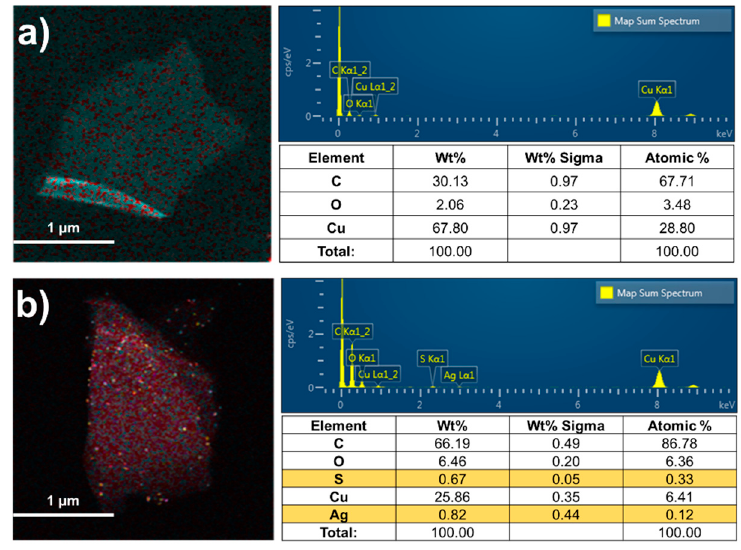
Figure 1. EDS analysis. ( a ) GO, ( b ) GCA 1:1 -AgNW.